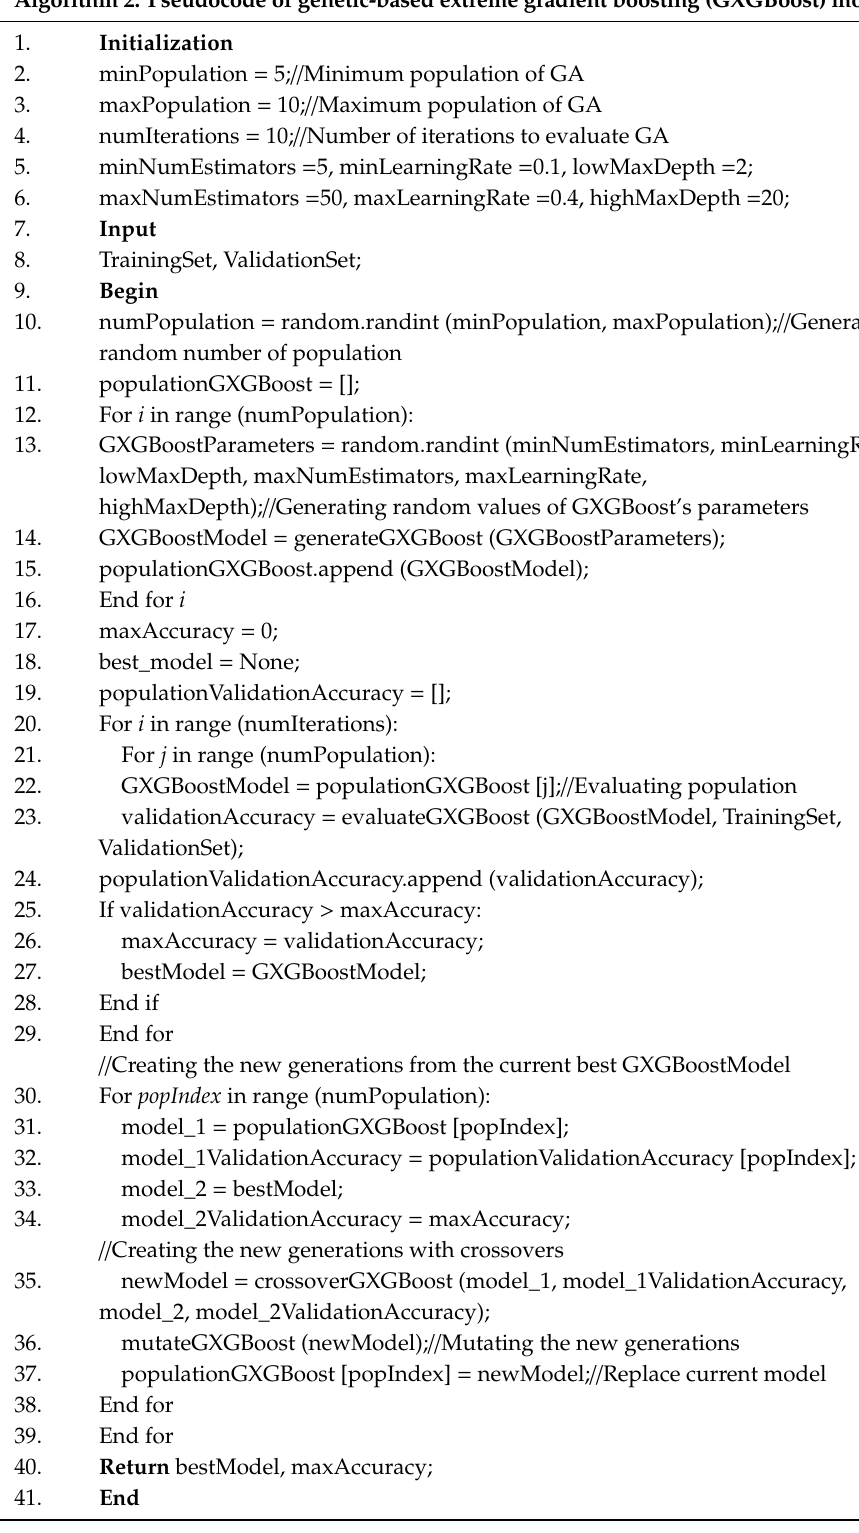
Algorithm 2. Pseudocode of genetic-based extreme gradient boosting (GXGBoost)